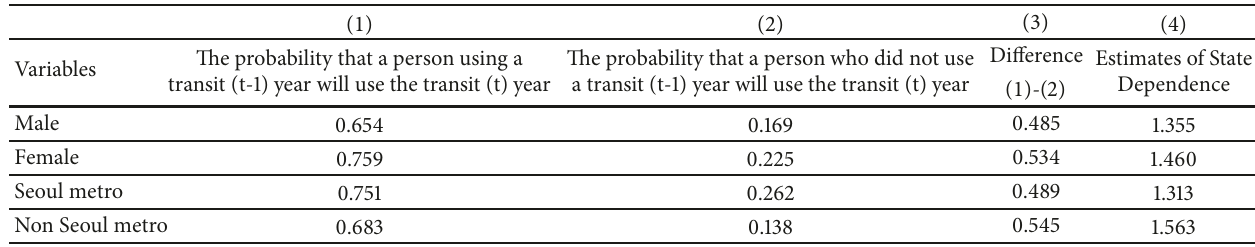
Table 10: Estimation of state dependence of transit users.